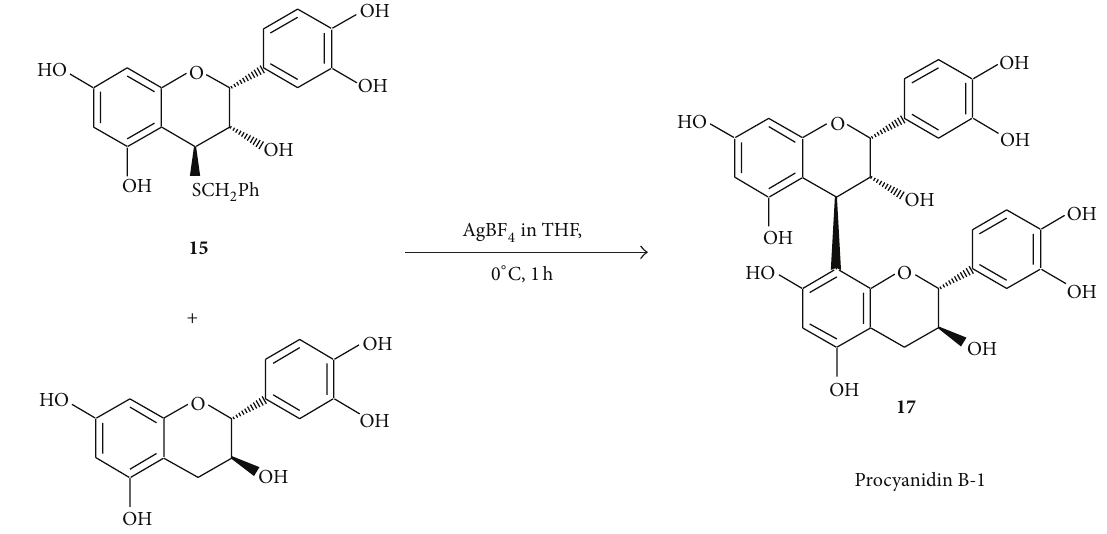
Scheme 1: Interflavanyl bond formation in procyanidins under neutral conditions.